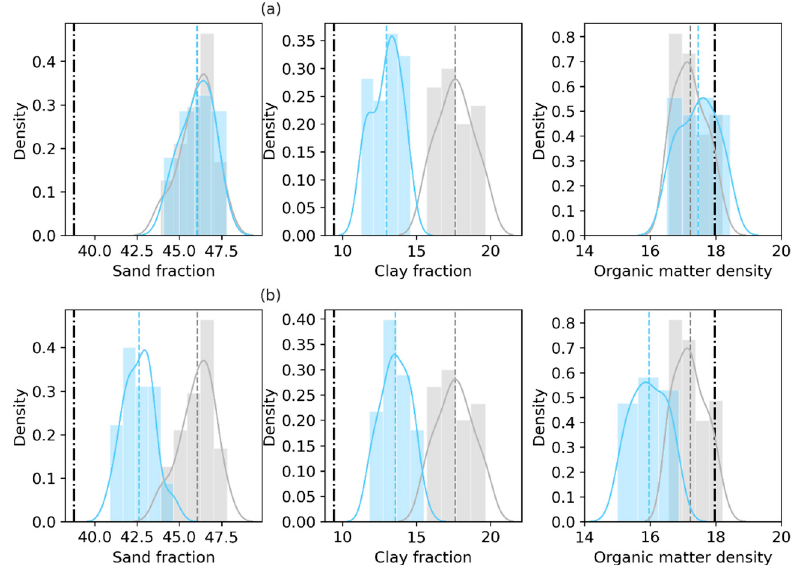
Figure 3. Prior and posterior distributions of the sand fraction (%), clay fraction (%) and organic matter density (kg/m 3 ) of the first layer, with the truth based on laboratory measurements of the 0–5 cm soil layer sampled in the field. The top panel labeled ( a ) displays the Only_Para experiment results based on SMAP 𝑇 (cid:3003) (cid:3009) assimilation. The bottom panel ( b ) displays the Joint_Updt experiment